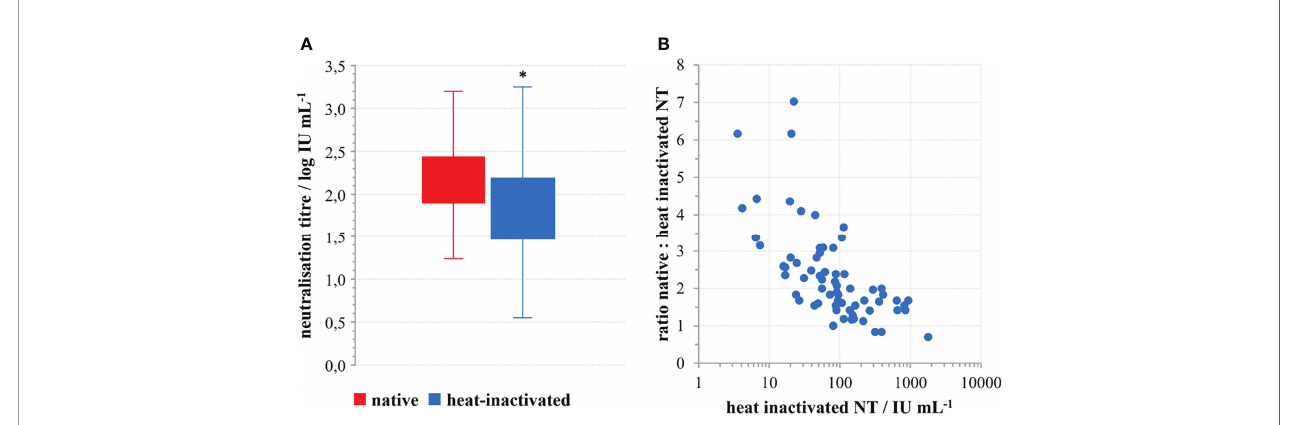
FIGURE 2 | The role of complement in SARS-CoV-2 neutralisation. (A) Decrease of SARS-CoV-2 neutralisation power of convalescent sera upon heat inactivation; * p <0.0001 ( n =69) according to the two-tailed t -test for paired samples; ( t =12.809; DF=68), (B) Factor of neutralisation titre decrease in relation to the quantity of neutralising antibodies in the convalescents